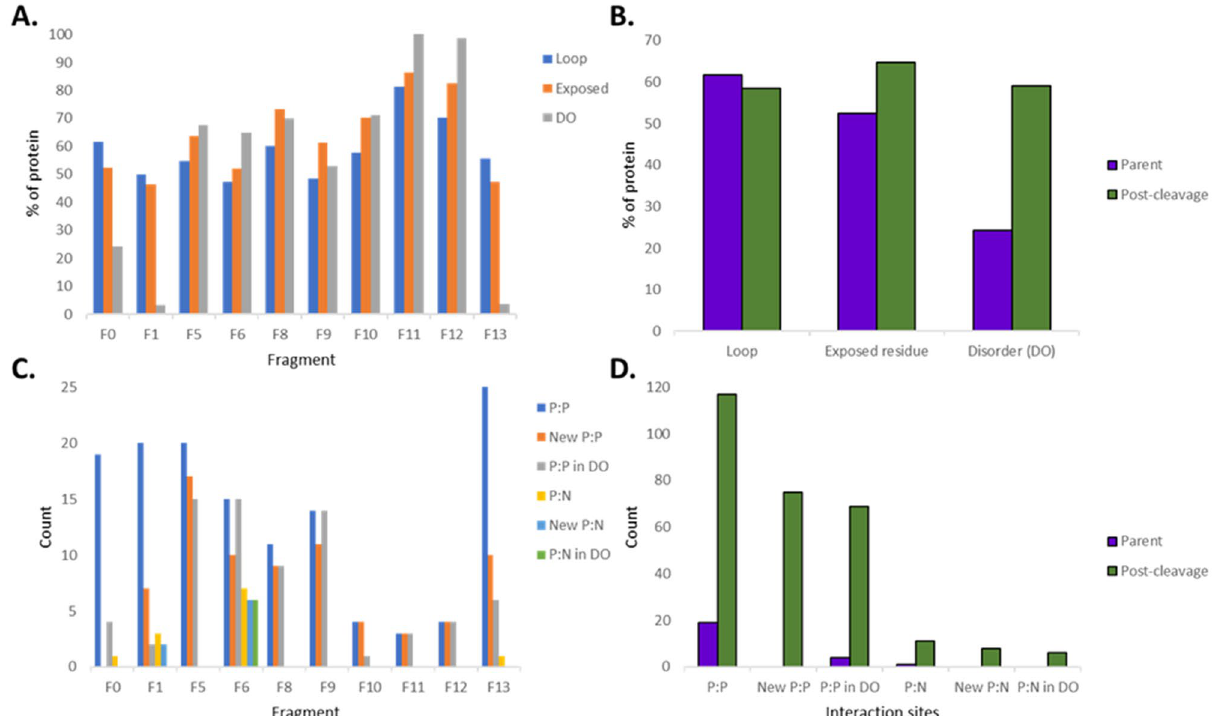
Figure 5. Predicted structural changes to uncharacterized lipoprotein MPN052 (P75062) post-cleavage. ( A ) The percentage of each fragment (F0 = full length) taken up by loop structures, exposed residues, disordered regions (DO). ( B ) Relative change in loop, exposed residues and DO pre- and post-cleavage. ( C ) The number of protein:protein (P:P) and protein:nucleotide (P:N) interaction sites per fragment. ( D ) Relative change in P:P and P:N sites pre and